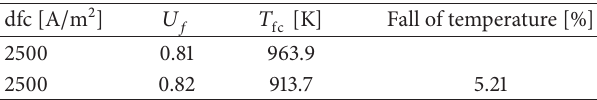
Table 6: Plan of the possible settings for low and medium flow rate of